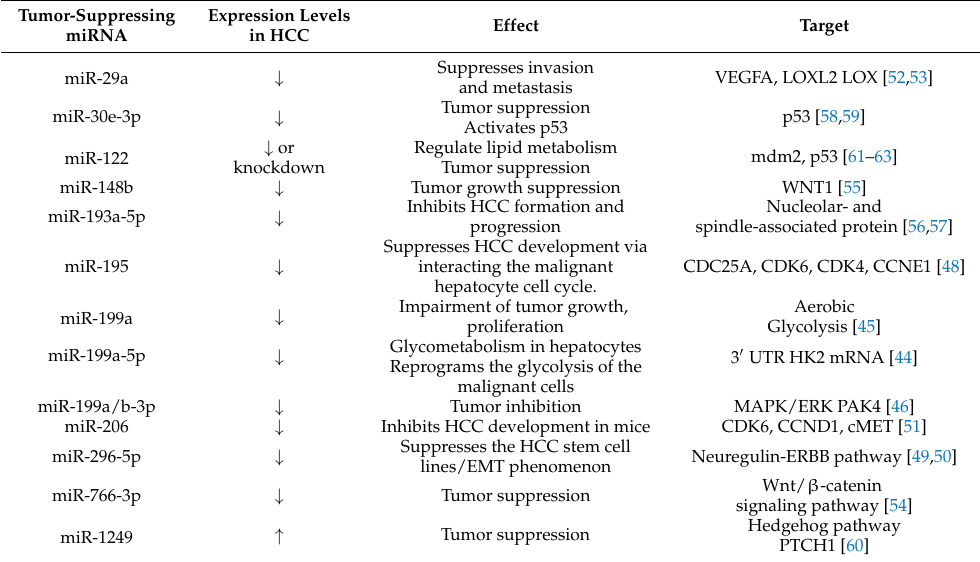
Table 2. A list of tumor-suppressive miRNAs in HCC and their effects and